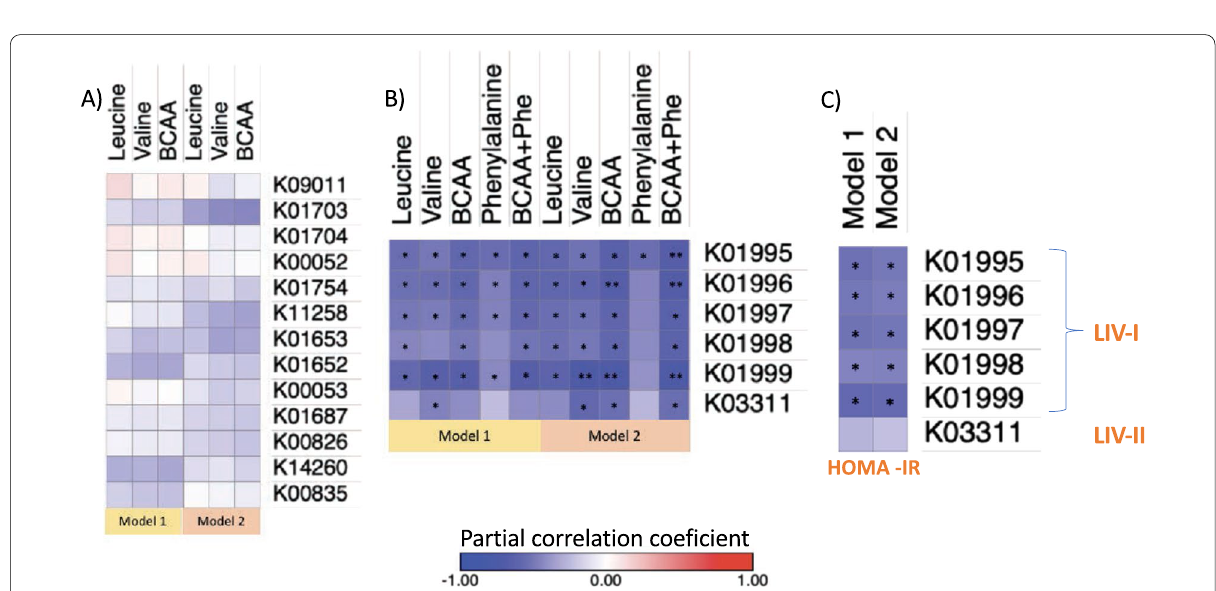
Fig. 2 Association of bacterial gene abundance with BCAA serum levels and HOMA‑IR. A heat map of the partial Spearman’s rank correlation coefficient between genes involved in BCAA biosynthesis and serum levels of BCAA. B heat map of the partial Spearman’s rank correlation coefficient between genes involved in BCAA transport and serum levels of BCAA. C heat map of the partial Spearman’s rank correlation coefficient between genes involved in BCAA transport and HOMA‑IR. P‑values were calculated using partial correlations adjusted for Model 1: age and sex. Model 2: Model 1 body fat percentage. False discovery rate (FDR) adjusted *P < 0.05, **P < +